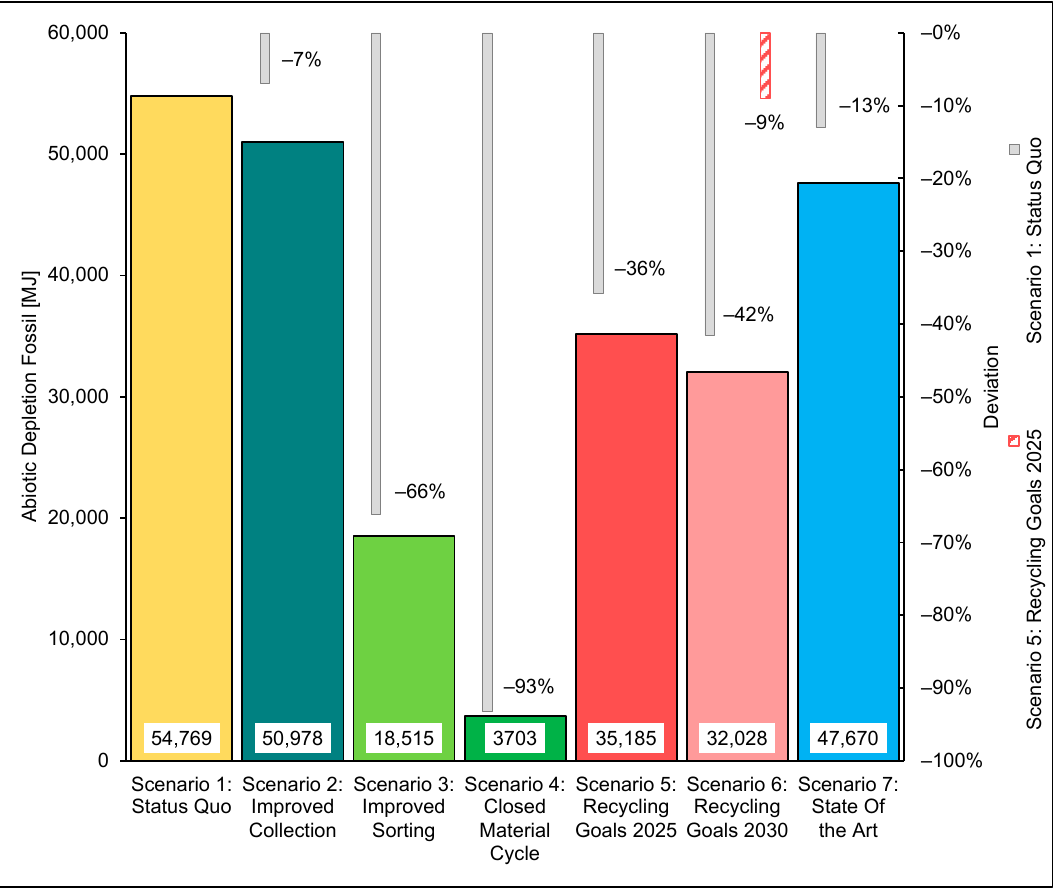
Figure 16. Abiotic Resource Depletion ADPF—Scenarios Overview.